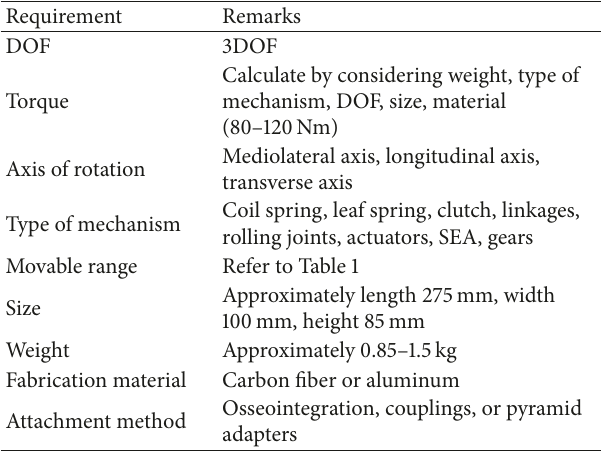
Table 2: Design requirements for a foot prosthesis